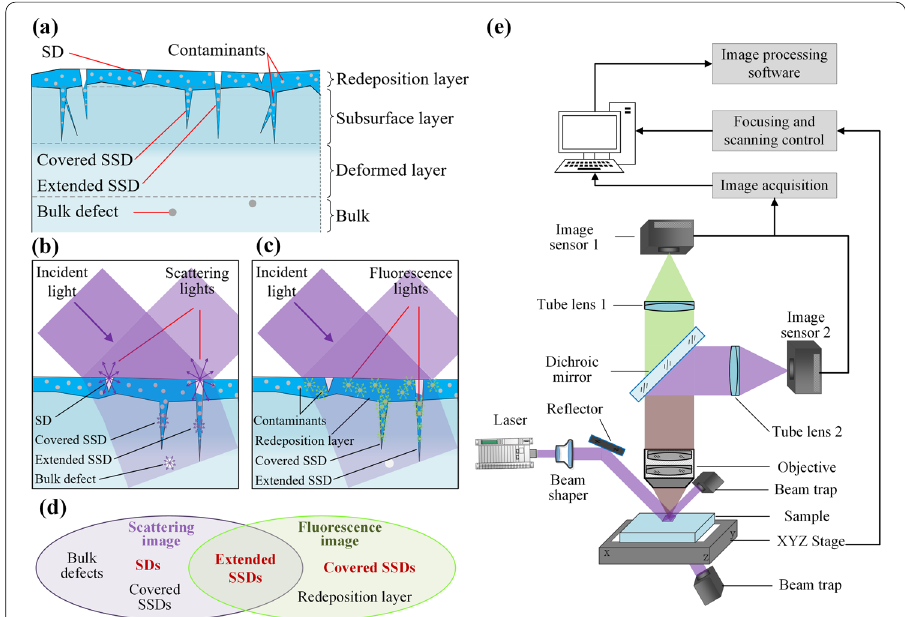
Fig. 1 Principle and layout of multisensor imaging system. a Surface and subsurface structure of polished optics. b Scattering imaging principle of defects. c Fluorescence imaging principle of defects. d Different types of defects characterized by scattering image and fluorescence image. e Layout of the multisensor detection